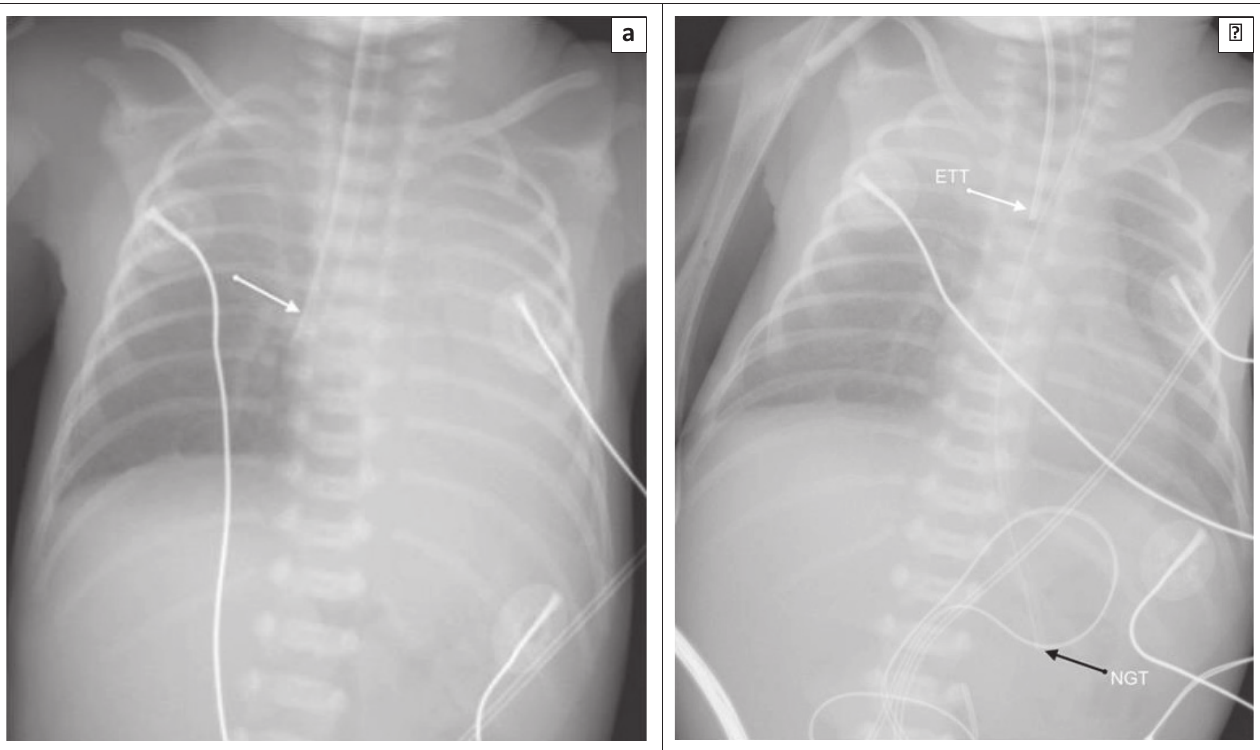
FIGURE 8: (a) The end of the endotracheal tube (ETT) (arrow) is lying within the right main bronchus. There is resultant left-sided atelectasis and mediastinal shift to the left. (b) The endotracheal tube (ETT) in Figure 8a has been withdrawn, and there has been re-expansion of the left lung. The NGT is within the stomach.